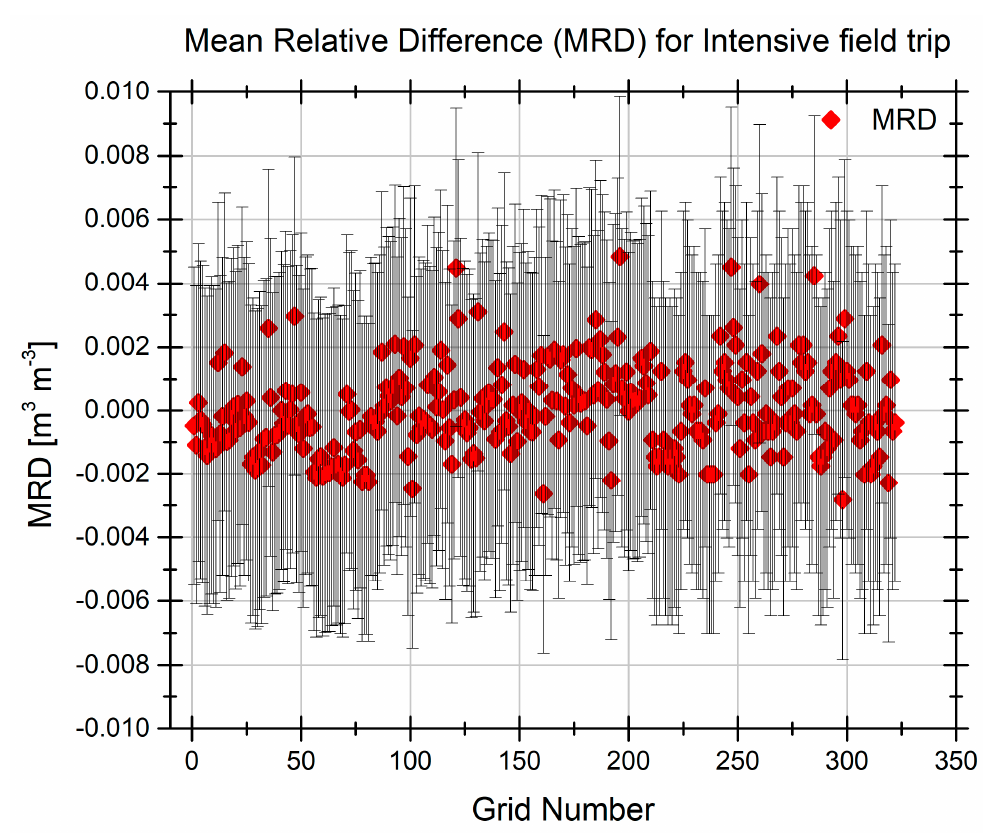
Figure 6. Mean relative di ff erence (MRD) of VSM, for 322 samples (20 February and 19 March 2016). The variability of the MRD values within that range during the two sampling days indicated the presence of di ff erences of soil moisture values within the study site, which could be attributed to the soil heterogeneity.